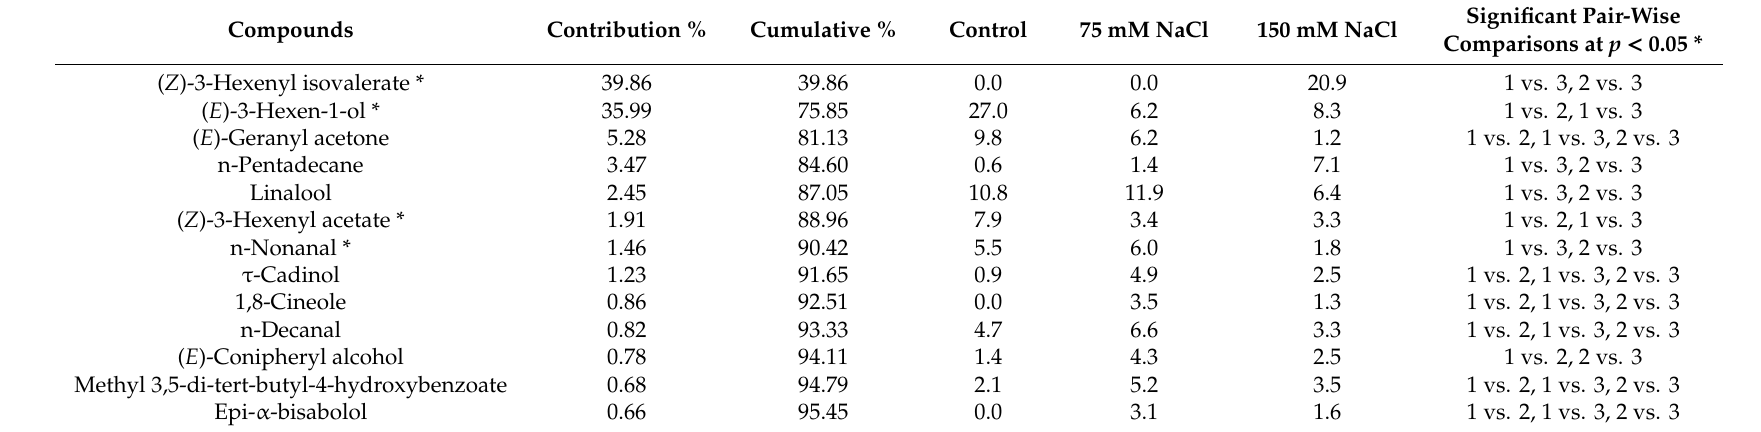
Table 6. List of compounds responsible for dissimilarity in L. inermis spontaneous emission according to the similarity percentage (SIMPER) analysis.